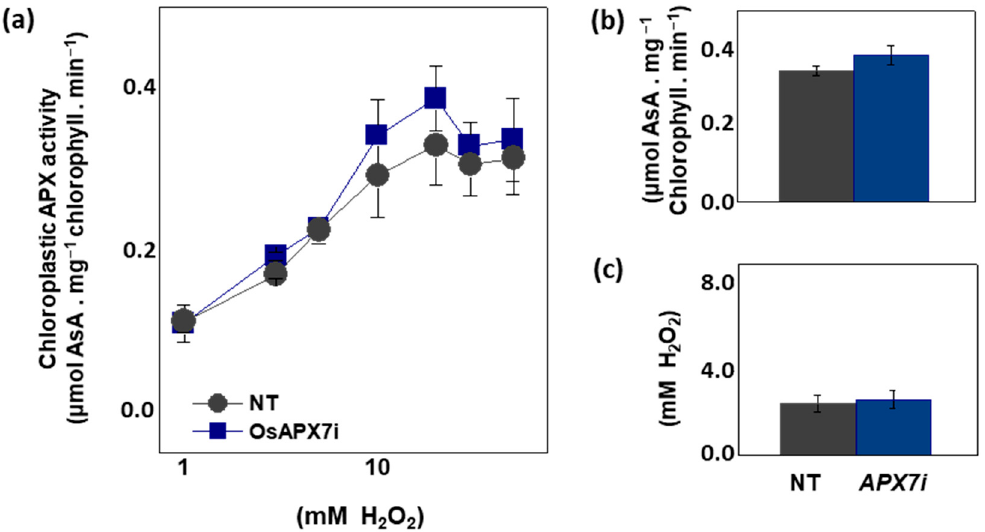
Figure 3. Chloroplastic APX activity and effect of MV treatment in chlorophyll content of Nipponbare (Nipp) and APX7i plants. ( a ) Measurement of APX activity under different H 2 O 2 concentrations in isolated chloroplast from Nipp and APX7i plant leaves. ( b ) V MAX of chloroplastic APX activity. ( c ) Apparent K M of chloroplastic APX to H 2 O 2 .